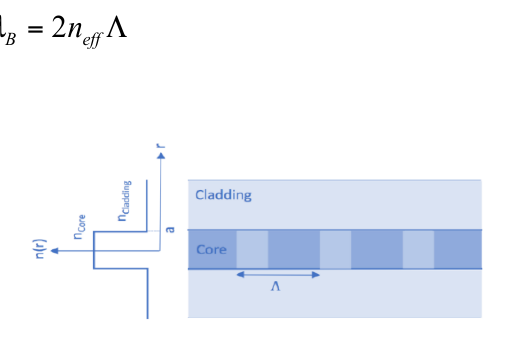
Figure 2: Fiber Bragg grating schematic